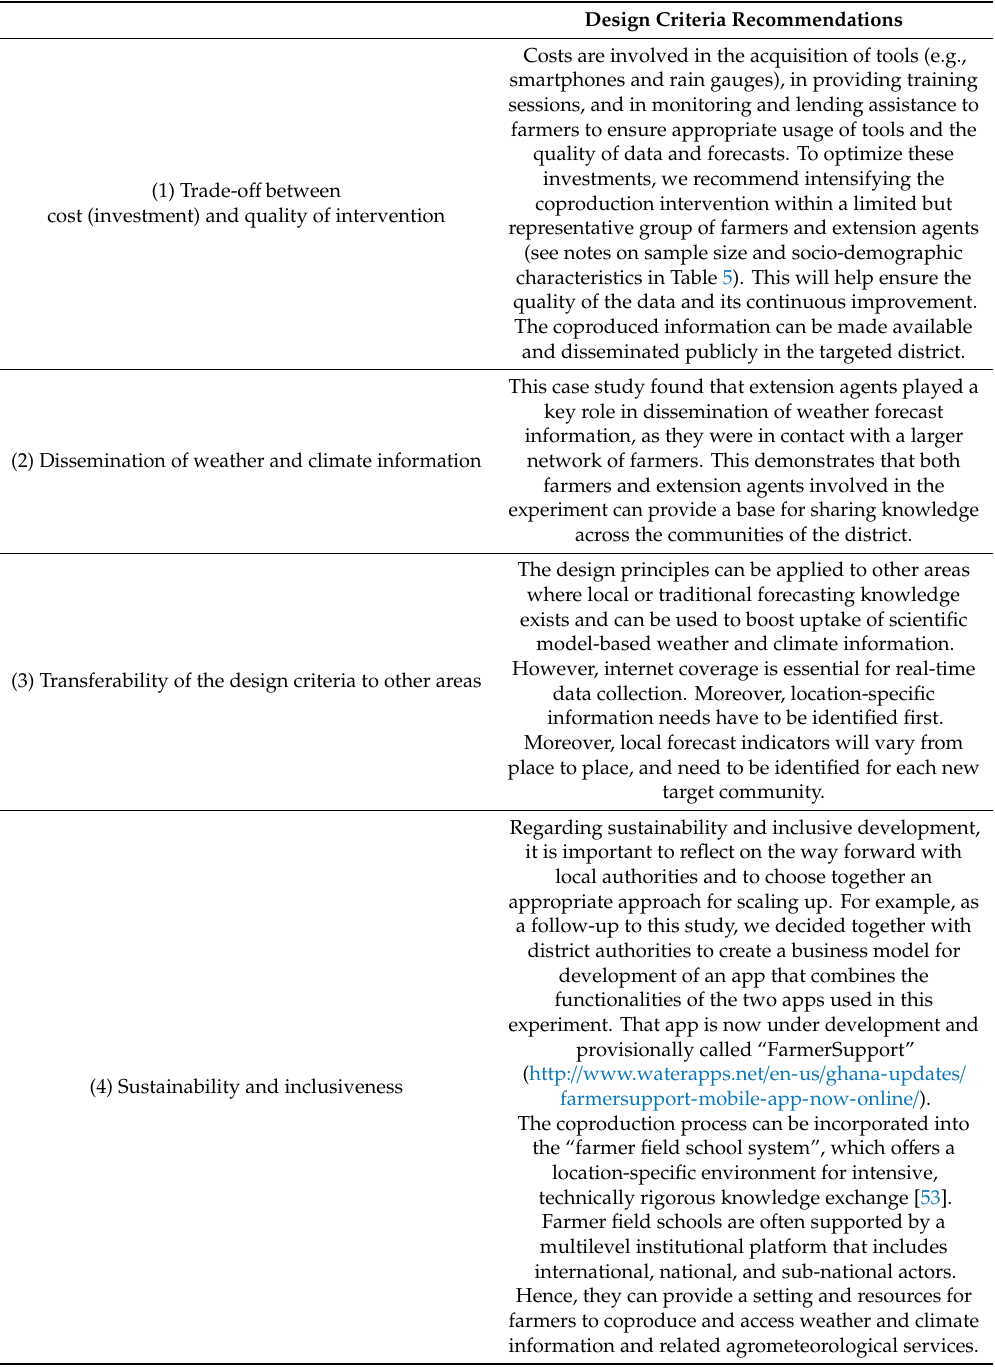
Table 6. Recommended design criteria or principles (in the scaling-up phase) for creation of an e ff ective weather and climate information system (WCIS) with and for smallholder farmers, combining local and scientific